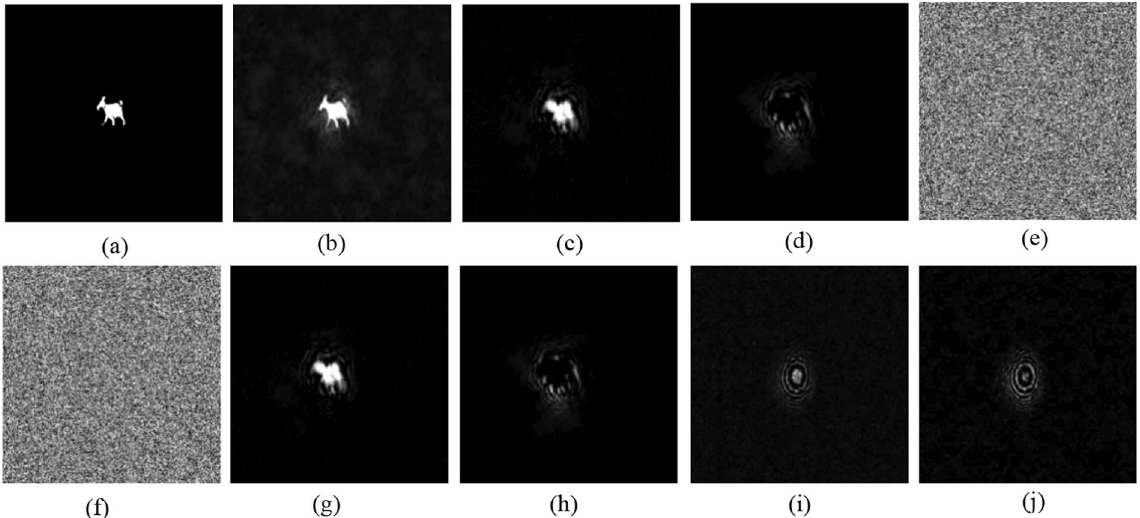
Figure 6. ( a ) Wrong private key w _ k b ; ( b , c ) are ( p 1 , p 2 ) , generated by w _ k b ⊗ K A in decryption; ( d , e ) are the corresponding cosine hologram w _ H Bc and sine hologram w _ H Bs , respectively; ( f ) decrypted image with wrong